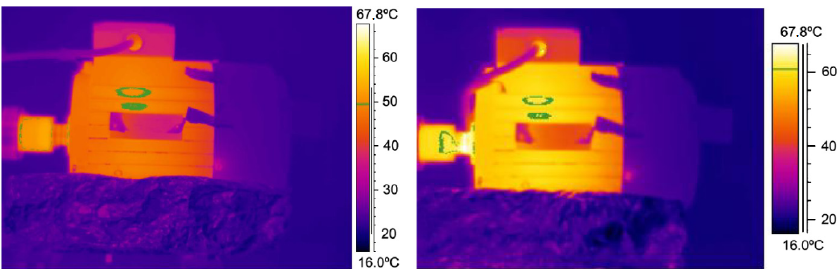
Figure 19. Comparison of a healthy and a non-healthy machine [79].